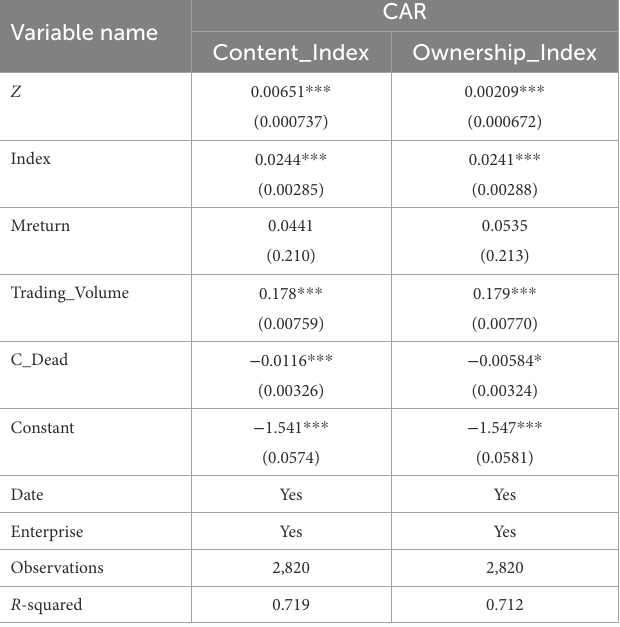
TABLE 4 Path test for the role of social concern.